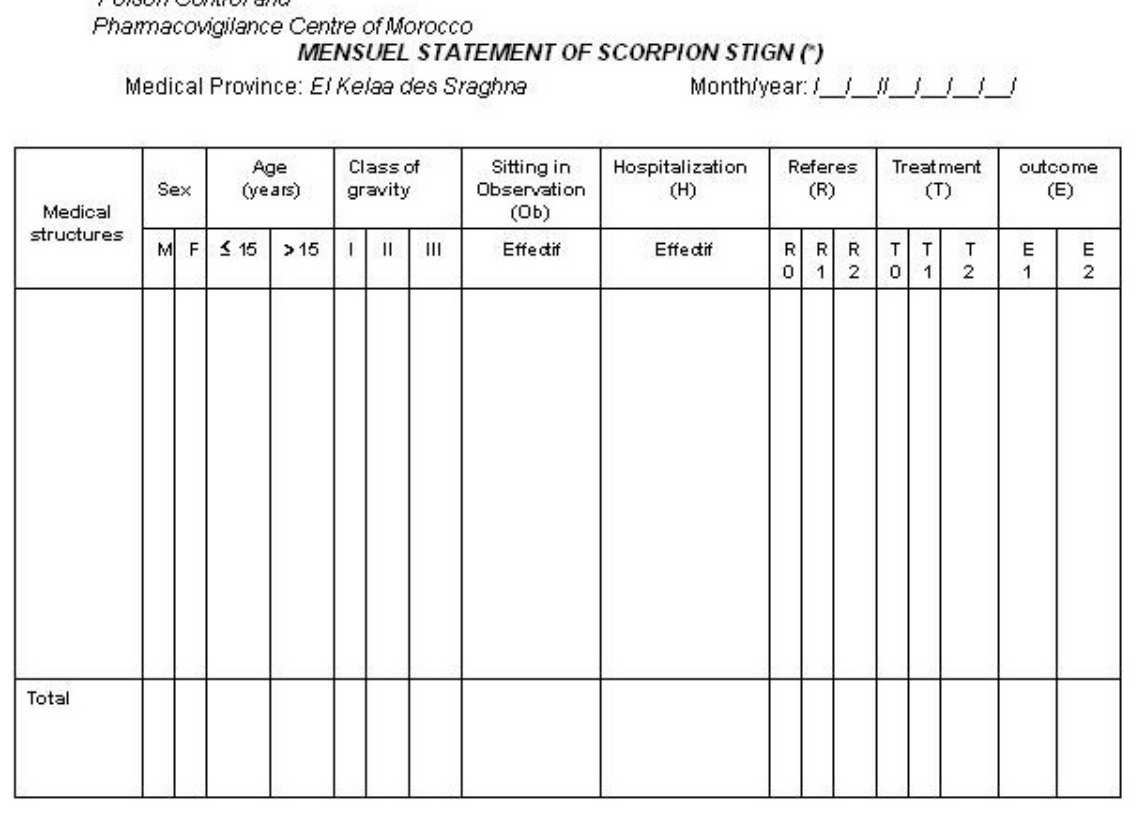
Figure 2. Model of the monthly statement about scorpion sting